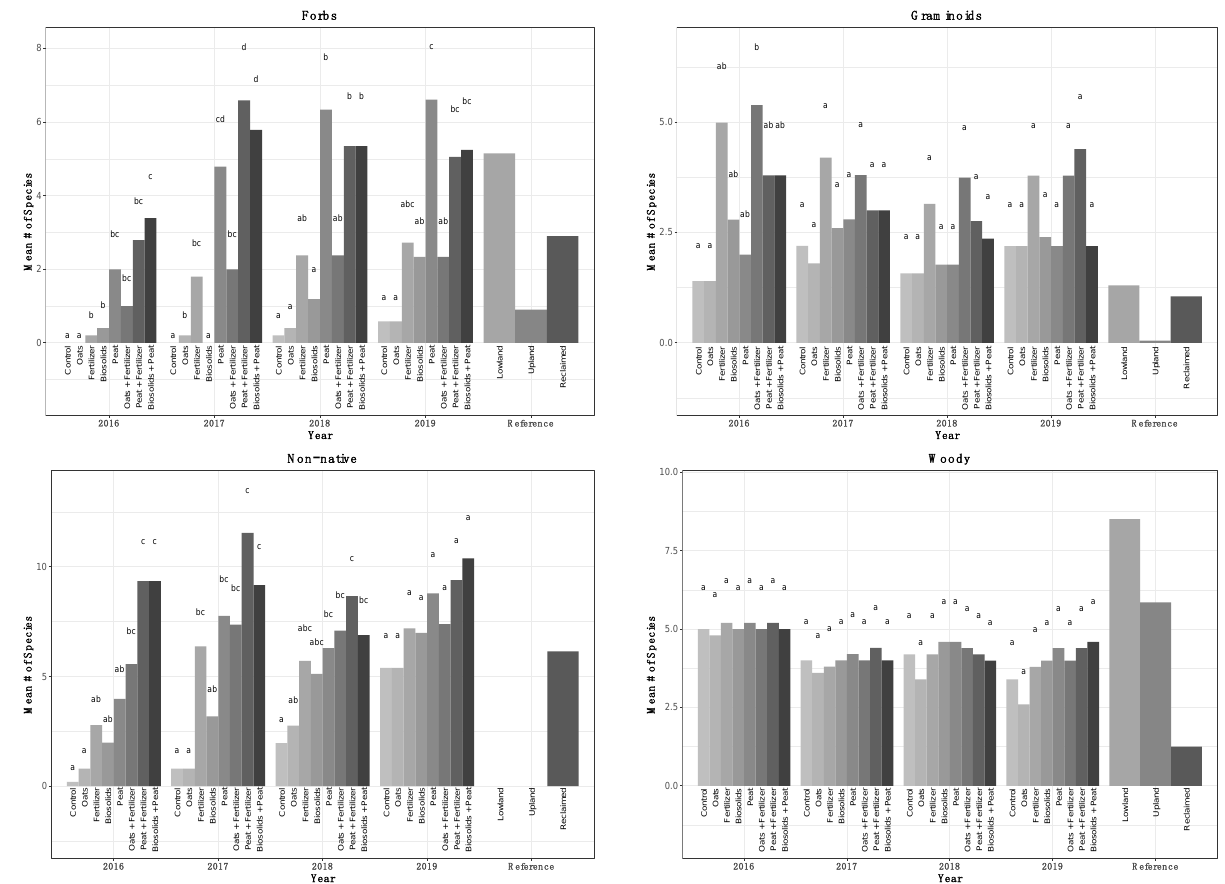
Figure 4. Mean functional group alpha diversity by treatment and reference site. Within each year, treatments marked with different letters indicates a statistically significant difference ( p < 0.05).